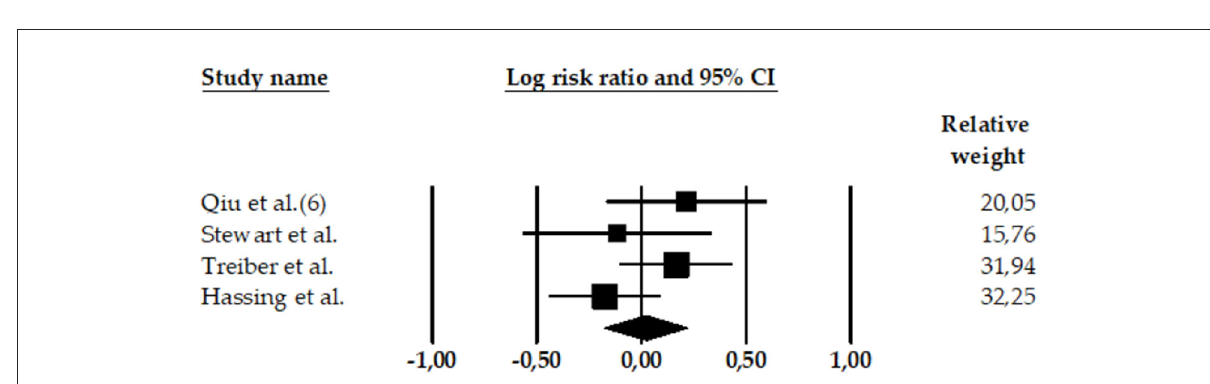
FIGURE4 Forest plot of the meta-analysis of rates of AD in participants with high BP (high SBP and high DBP). The size of the box representing the point estimate for each study in the forest plot is proportional to the contributing weight of that study estimate to the summary estimate.